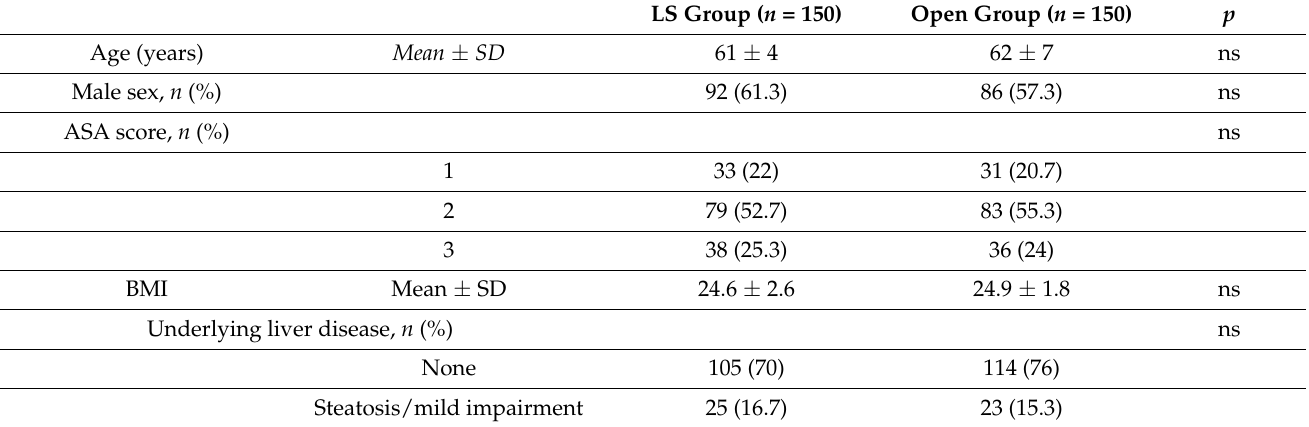
Table 1. Patients and disease characteristics after propensity score